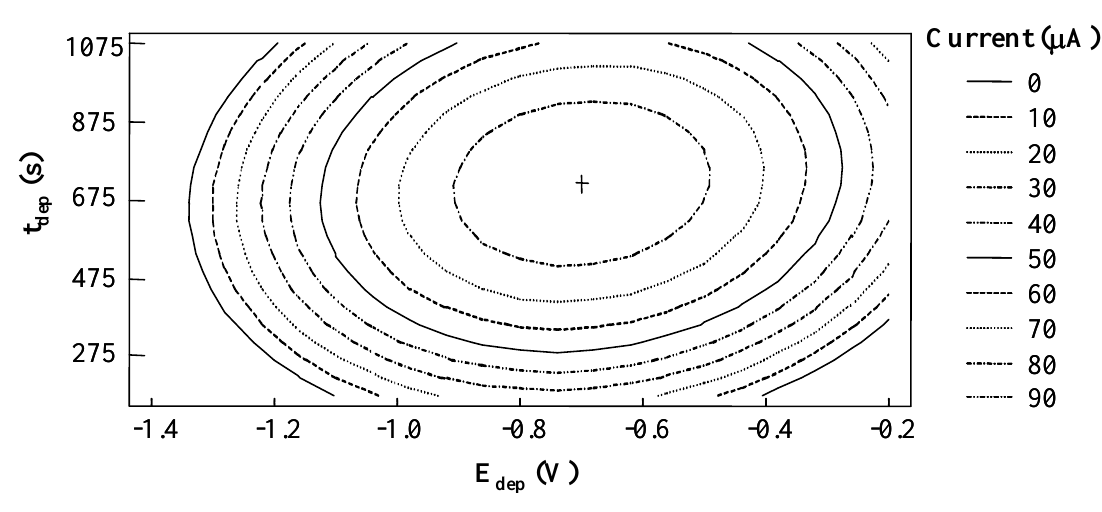
Figure 3. Level curves for the 2 2 central composite design for optimization of experimental variables in Sb (III) determination by